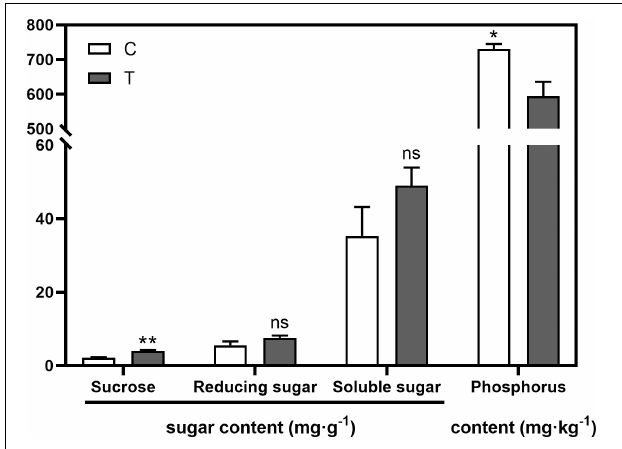
FIGURE 1 | The influences of arbuscular mycorrhizal fungus (AMF) on contents of sugar in tea plant root and phosphorus in shoot. “*” and “**” mean significant difference at p < 0.05 and p < 0.01, respectively. “ns” was short for “no